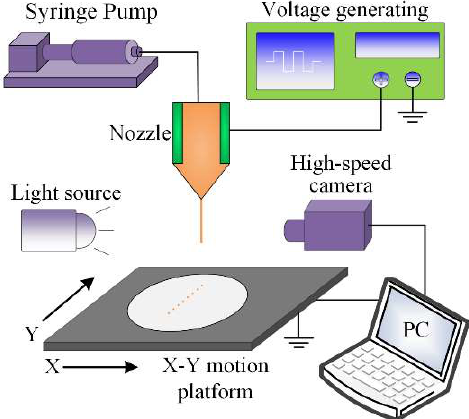
Figure 6. Schematic diagram of electrohydrodynamic jet (E-jet) printing system for experiment.